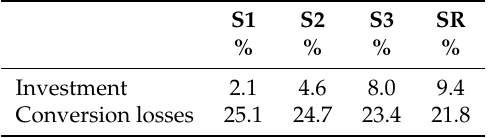
Table 11. Share of investment and conversion losses on the total CExC